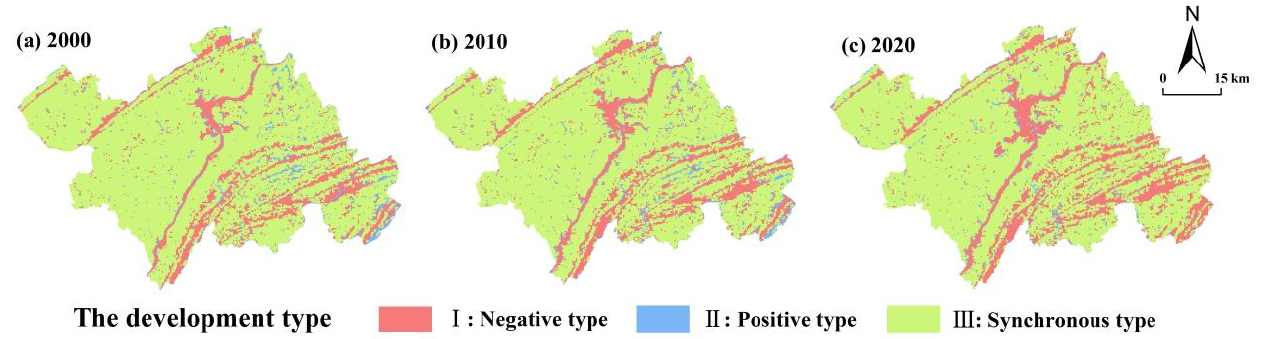
Figure 9. The development type of the PLEF coupling coordination degree and HAI in 2000(a), 2010(b), and